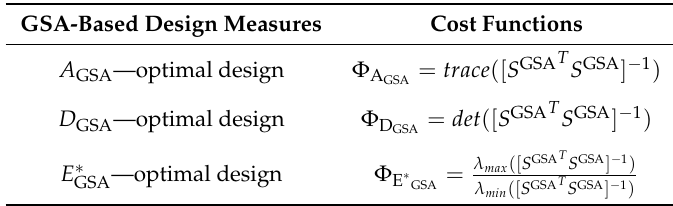
Table 4. Generalized local design measures including global